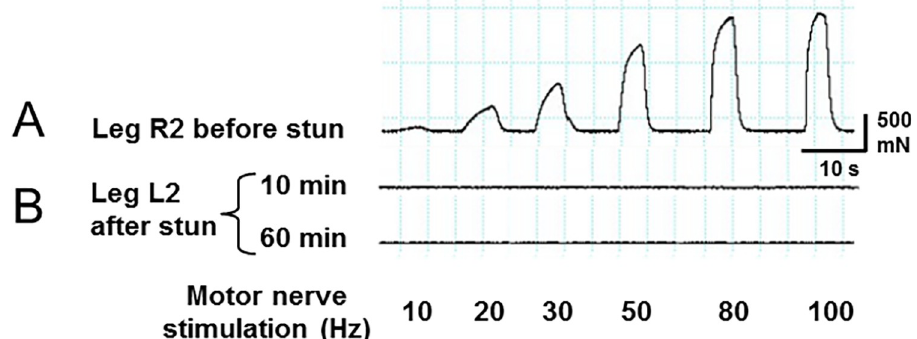
Fig 8. Recording motor output before and after electrical stunning. Forces produced by the dactylopodite closer muscle of the leg of C . pagurus in response to stimulation of motor neurones in the leg nerve at various frequencies. A: leg R2 autotomised from intact crab; B: leg L2 amputated from the same crab after electrical stunning, measured at 10 min and 60 min post-stun. Stimulus voltage 4V.